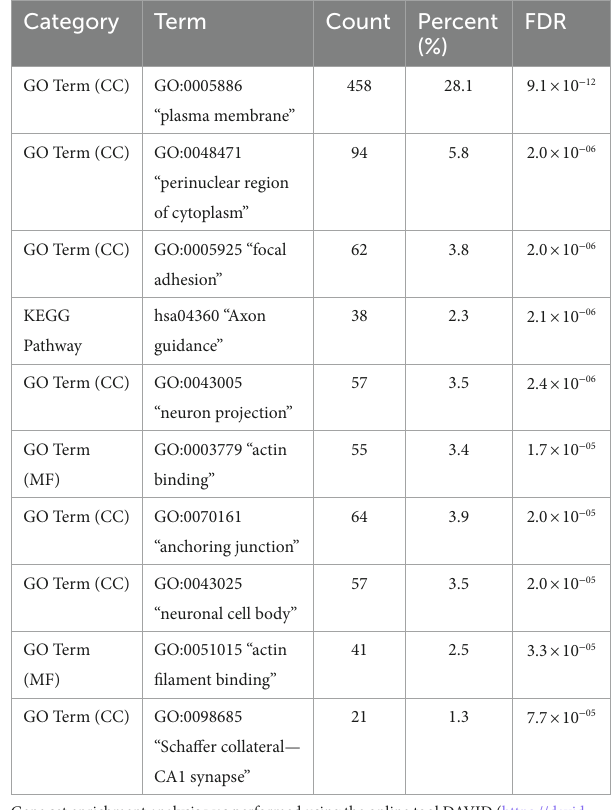
TABLE 3 Top-10 enriched functional annotations for differentiated 5hmC sites (nominal p < 0.05) with reduced NSC expression (3,432 sites localized to 1,627